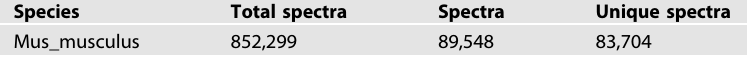
Table 1. Protein identi fi cation overview of iTRAQ quanti fi cation.